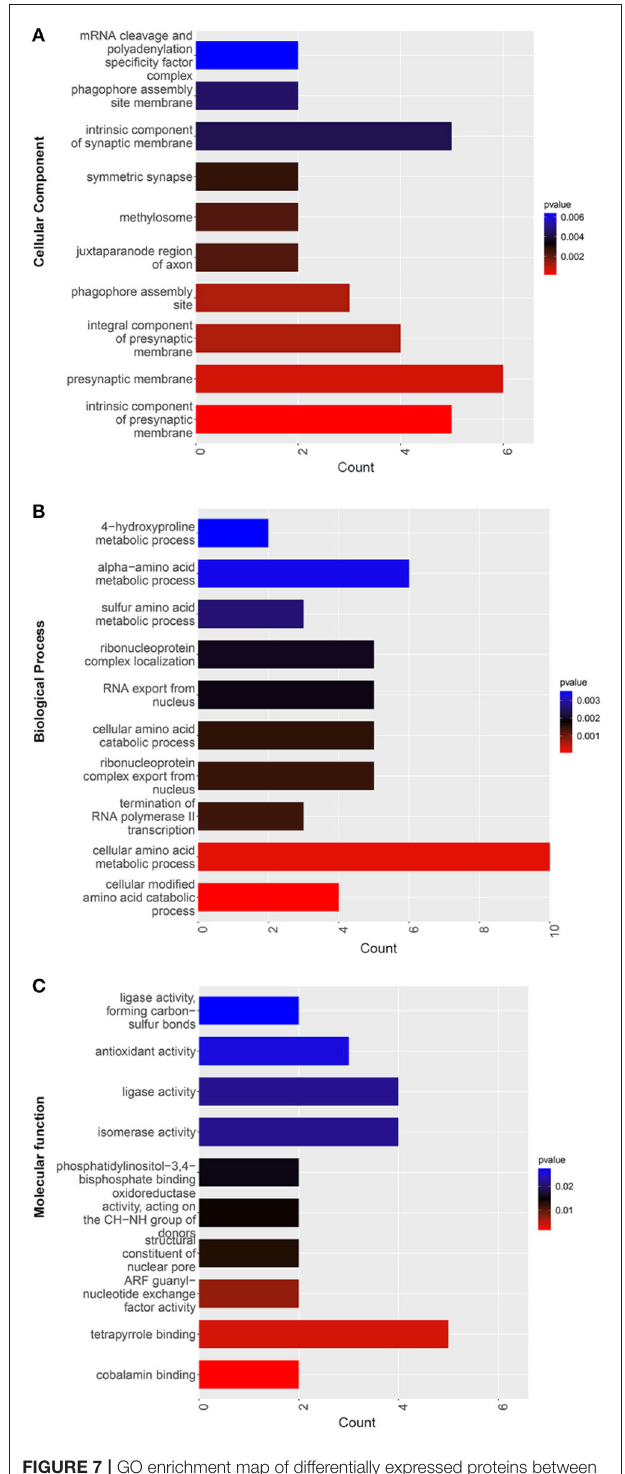
FIGURE 7 | GO enrichment map of differentially expressed proteins between the TSC1 truncating mutation group and the control group. The y-axis represents the classification of differentially expressed proteins according to (A) Gene Ontology Cellular Component (GO CC), (B) Gene Ontology Biological Process (GO BP), and (C) Gene Ontology Molecular function (GO MF). The x-axis is the count of differentially expressed